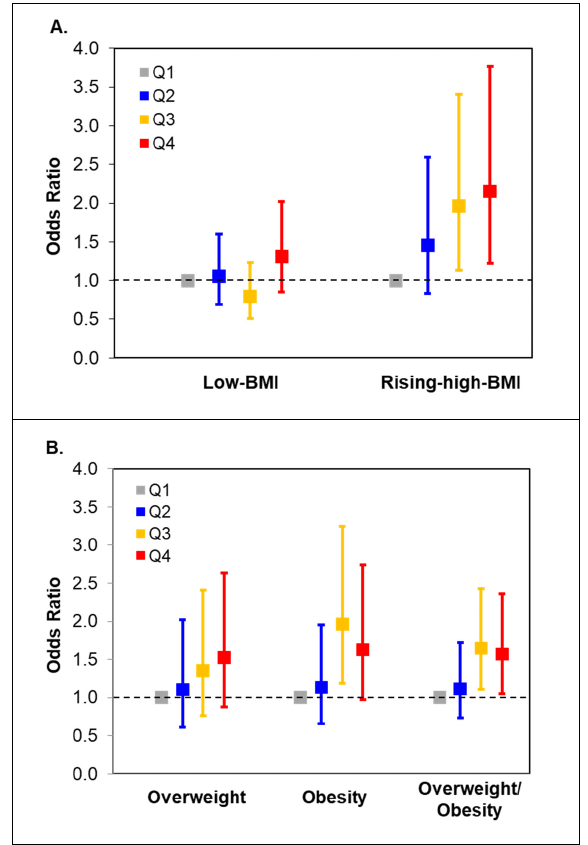
Figure 1. Odds ratios (95%CI) for child growth trajectories ( A ) and overweight / obesity ( B ) across maternal quartiles of the fast food pattern score.